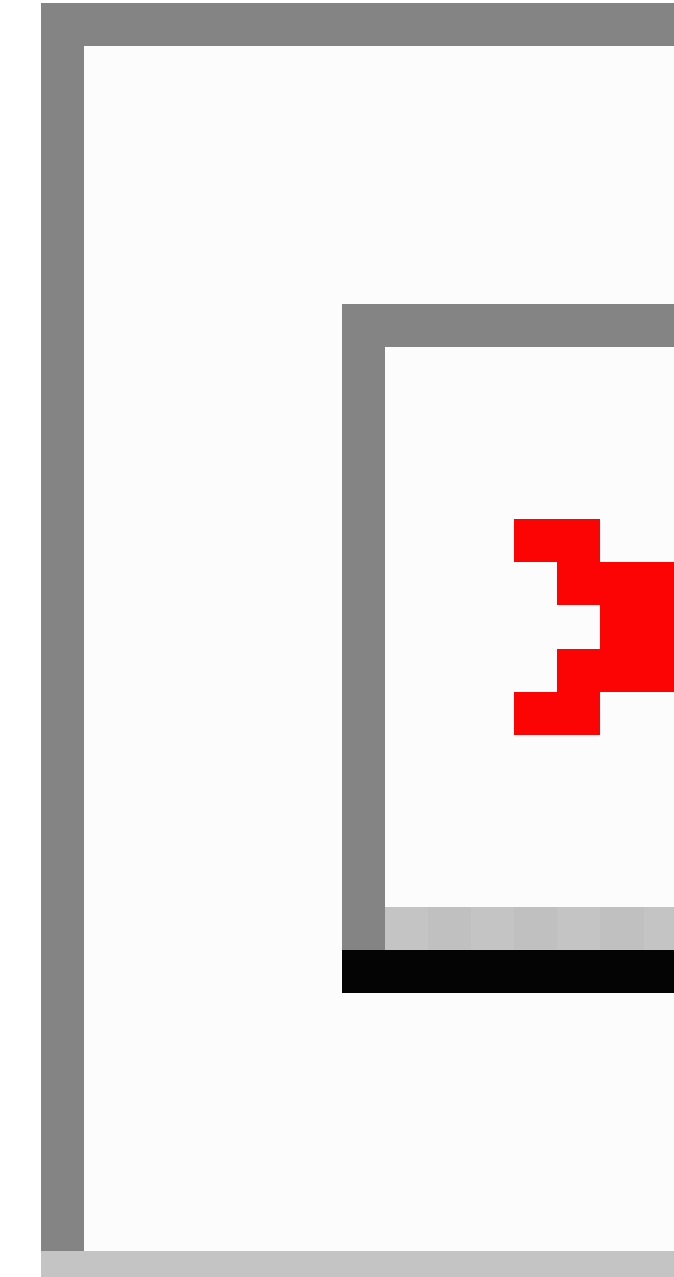
Figure 3. Home screen of the social version, showing the high-score